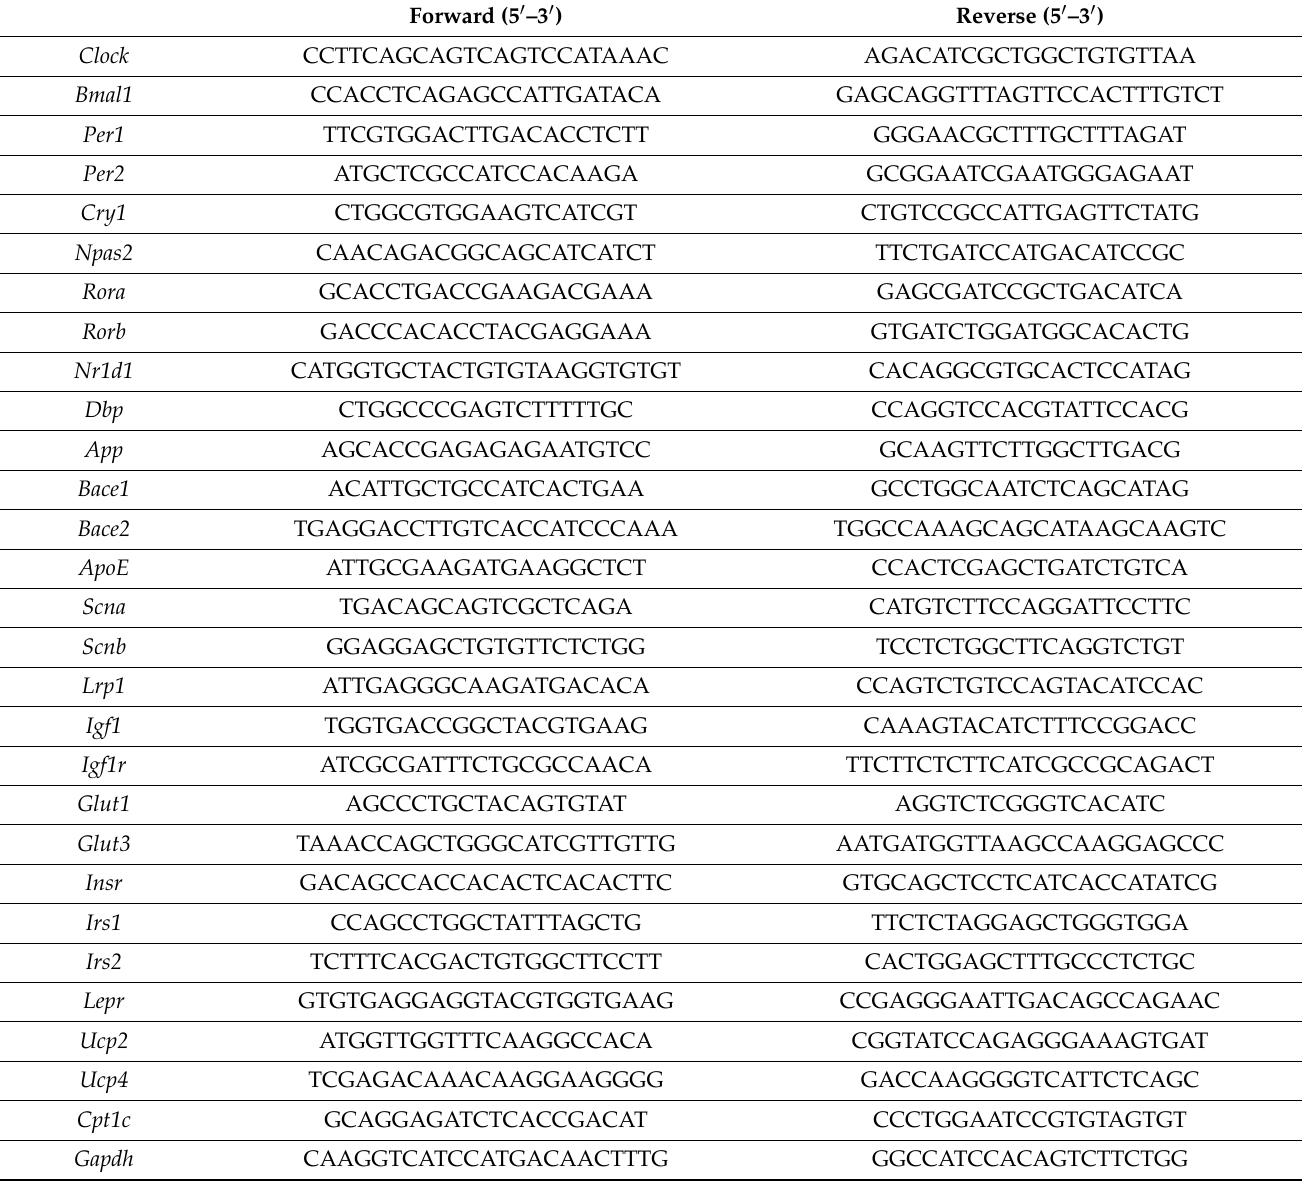
Table 1. Primer sequences for